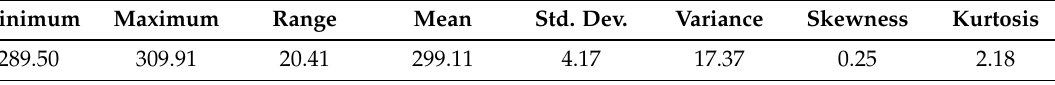
Figure B2. Histogram plot of dew-point air temperature data collected by SRNL from F-Area cooling towers (unsaturated conditions). Table B5. Statistics of the dew-point temperature distribution [K]. Minimum